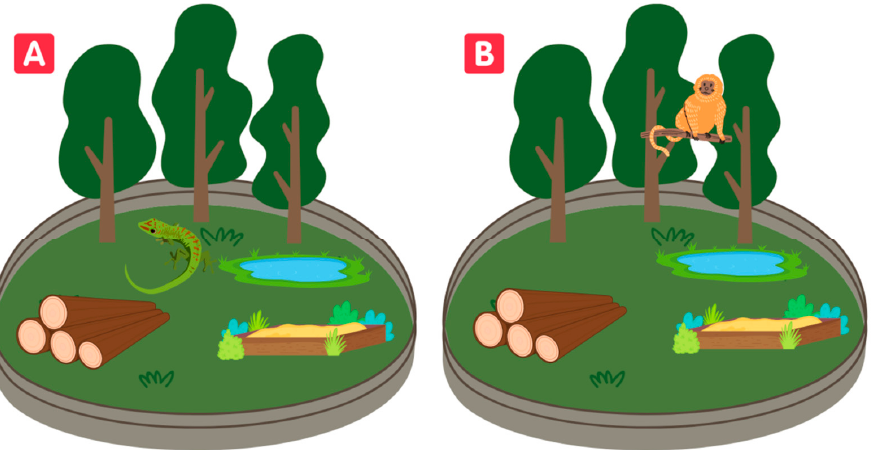
Figure 2. Habitat complexity can be perceived differently depending on the species living in the enclosure. Habitat complexity can be high for a lizard ( A ) and low for a monkey ( B ), even when evaluating the same enclosure.